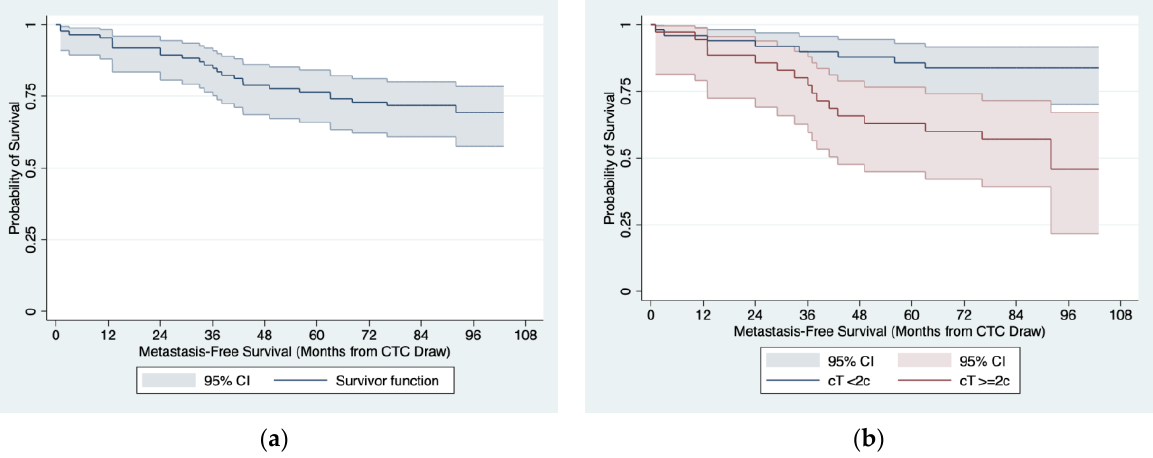
Figure 1. MFS estimates in 85 patients with localized PCa at baseline: ( a ) entire cohort; ( b ) by cT status at the baseline. Table 3. Univariate analyses for MFS in 85 patients with localized PCa at baseline. Variable